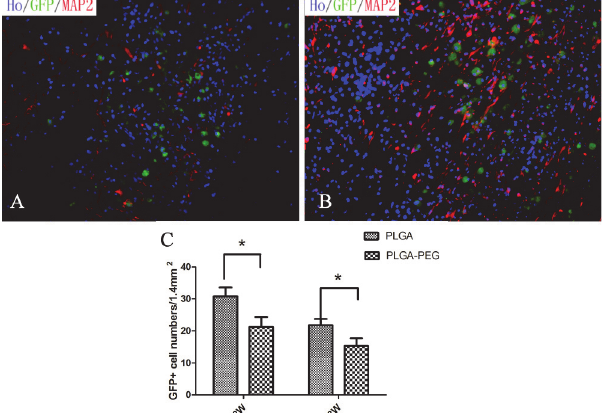
Fig 13. The long-term survival of transplanted cells in vivo. 8 weeks after transplantation, we can still see abundant MAP2/GFP-positive cells in PLGA-PEG group (B). However, only a small amount of GFP-positive cells was observed in PLGA group (A). Quantitative analysis revealed the numbers of GFP+ cells in PLGA-PEG group were significantly greater than PLGA group in 2 weeks and 8 weeks post-transplantation (P < 0.05, Student t-test, n = 5) (C). Scale bars = 100 μ m (E,